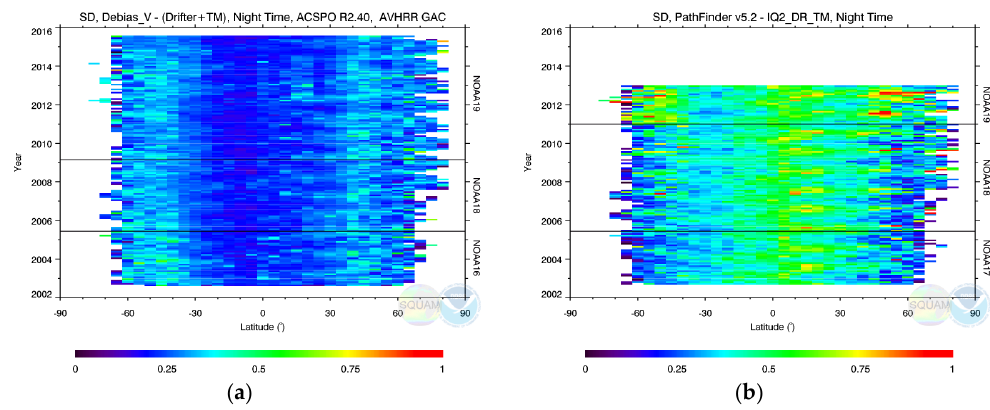
Figure 14. Same as in Figure 12 but for the corresponding SDs.: ( a ) RAN1; ( b ) PFV5.2.